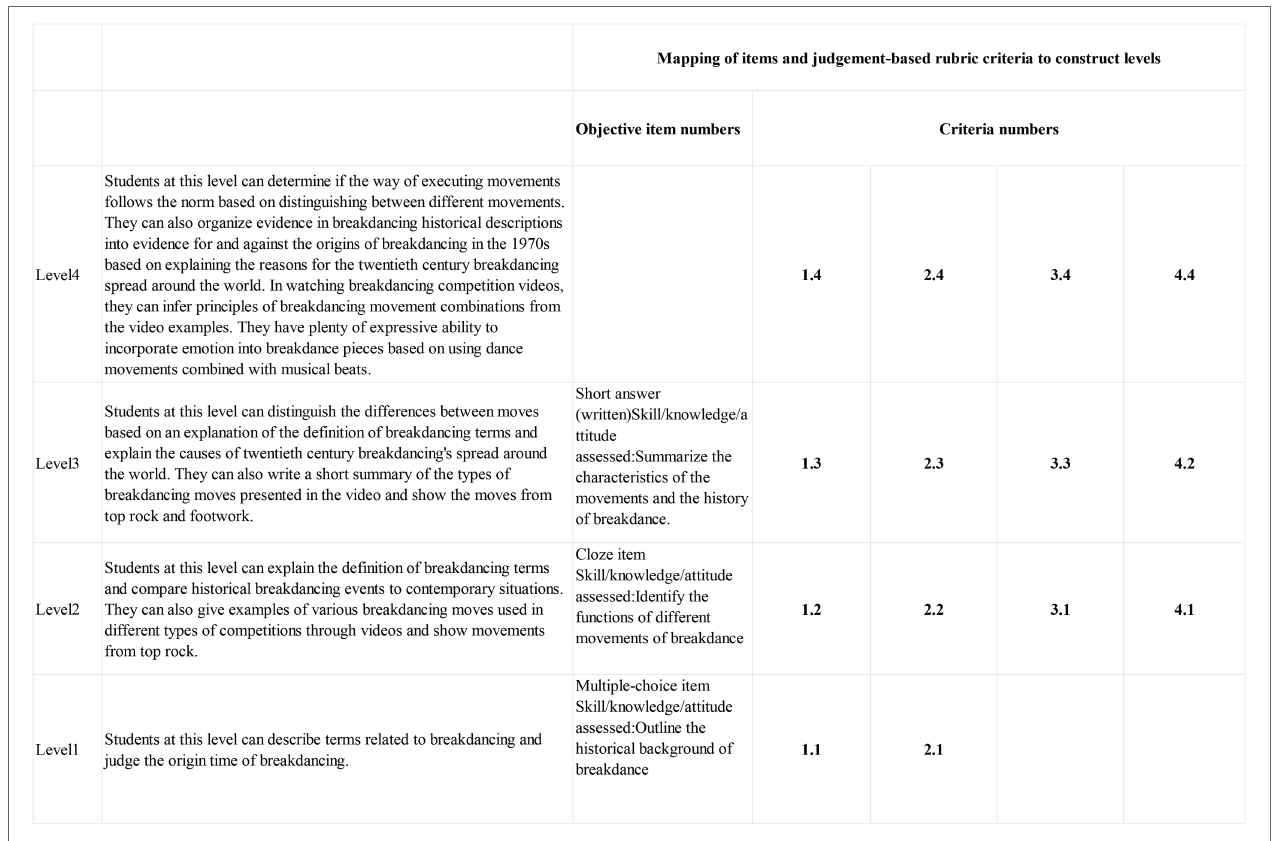
FIGURE 1 | Student Capability Progress Level